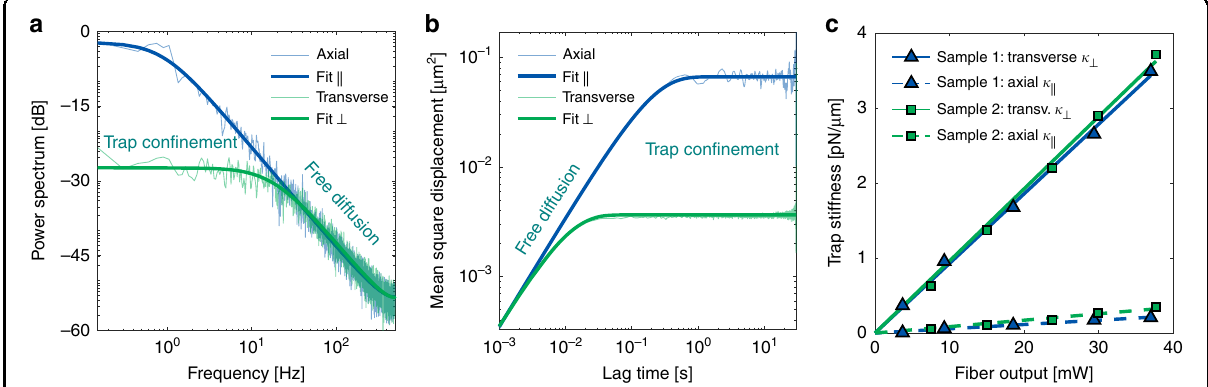
Fig. 5 Analysis of the results from trapping silica beads using the UNM-enhanced fi bre. a Power-spectral-density (PSD) analysis of a representative dataset (shown in Fig. 4d), including the corresponding fi ts (thick lines) for the axial (blue) and transverse (green) directions. b Corresponding mean-square-displacement (MSD) analysis for the same dataset including fi ts. c Resulting trap stiffness at different power levels for both samples (sample 1: NA = 0.84, sample 2: NA = 0.88, for details, see Fig. 2b) determined using the MSD method (Fig. 5b). As expected, a higher NA yields stronger trapping, while the transverse stiffness is approximately one order of magnitude higher than that in the axial direction (compare ref. 13